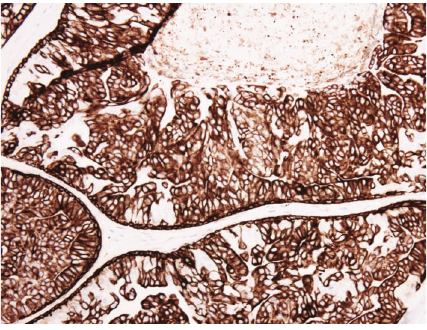
Figure 5: CK 5/6 immunostaining, ×